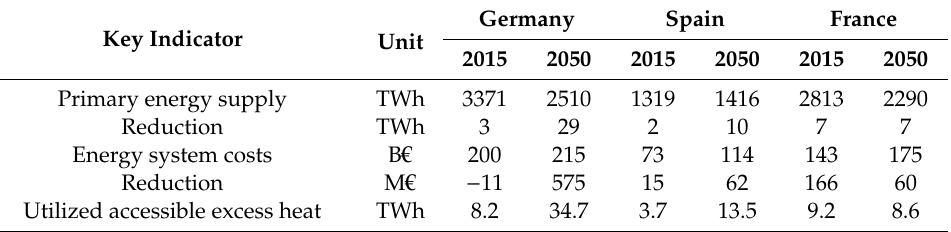
Table 4. Summary of key indicators from the combined country scenarios for 2015 and 2050. Key indicator